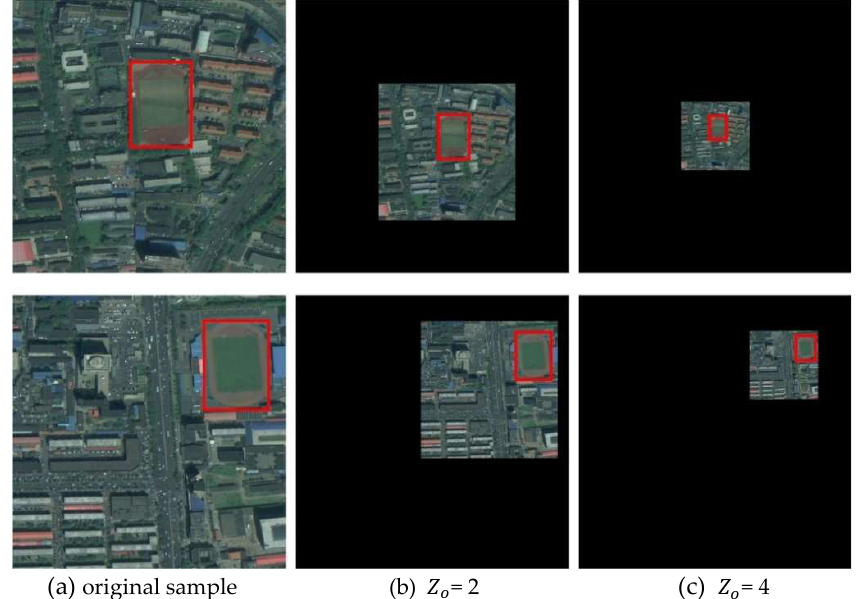
Figure 15. Visualization of “zoom out” operation, the track and field is inside the red box: ( a ) The original sample; ( b ) The data-enhanced sample after 2× “zoom out”; ( c ) The data-enhanced sample after 4× “zoom out”.